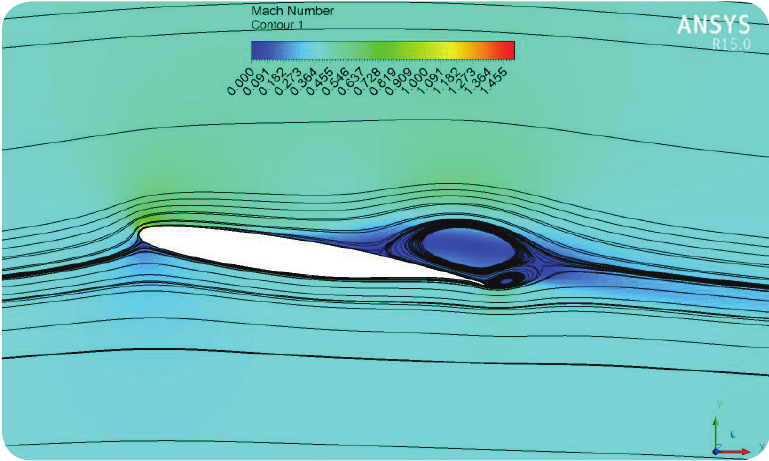
Figure 33. Mach contour, pitch motion α(t) = 3 + 3 sin( w t), frequency = 3 Hz, Mach = 0.4, Alpha = 6°.